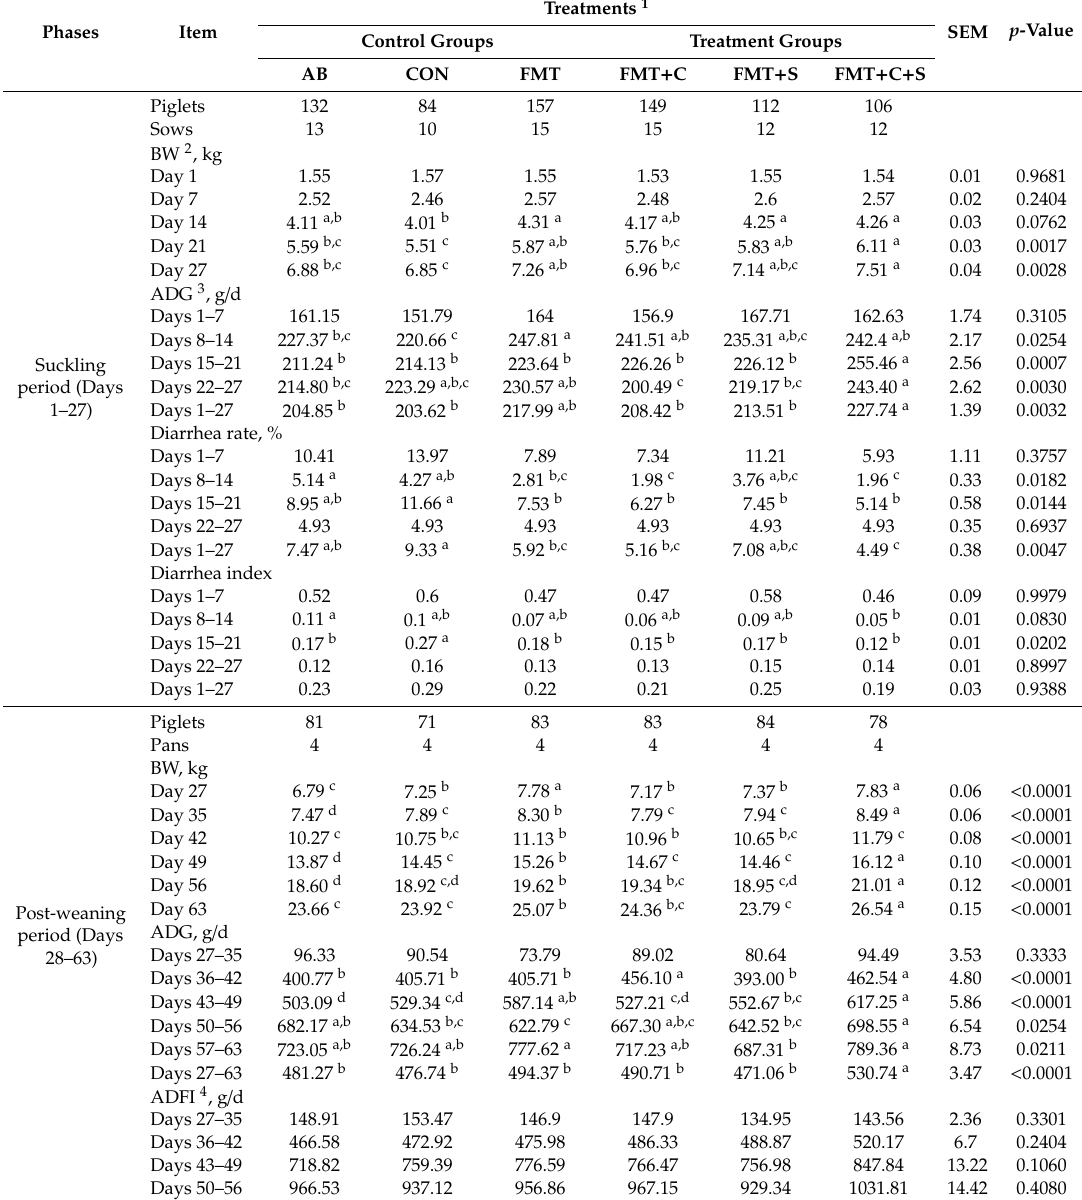
Table 2. E ff ects of early intervention on growth performance of piglets during suckling and post-weaning